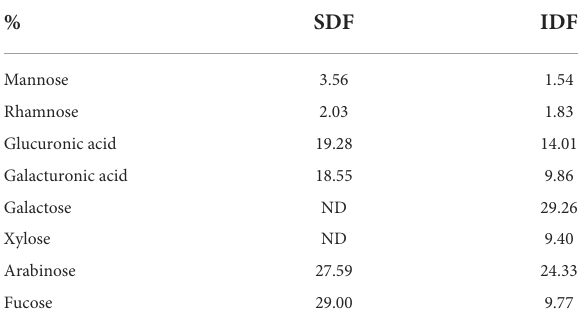
TABLE 2 Monosaccharide composition of SDF and